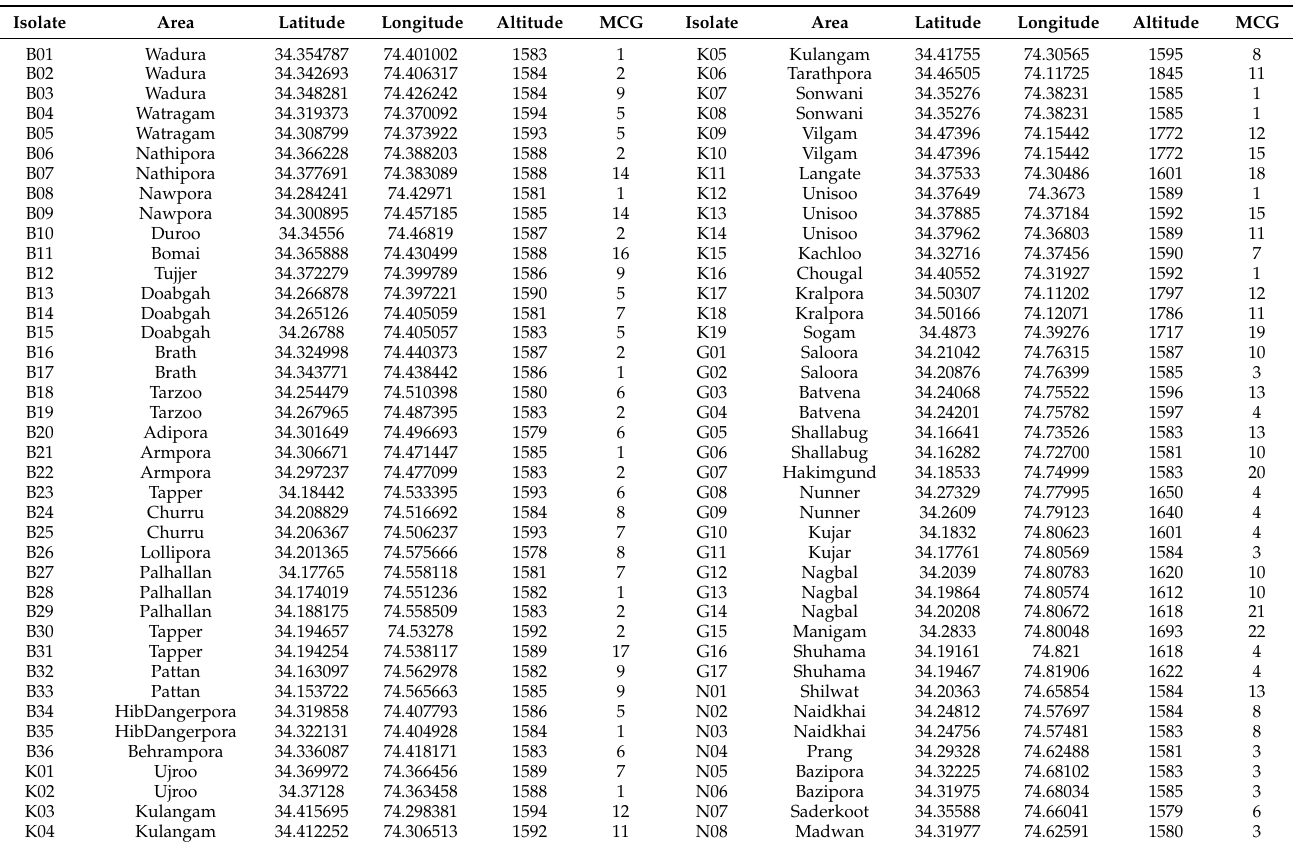
Table 2. Collection sites with topographic data of 80 Isolates of S. sclerotiorum collected from bean plants in North